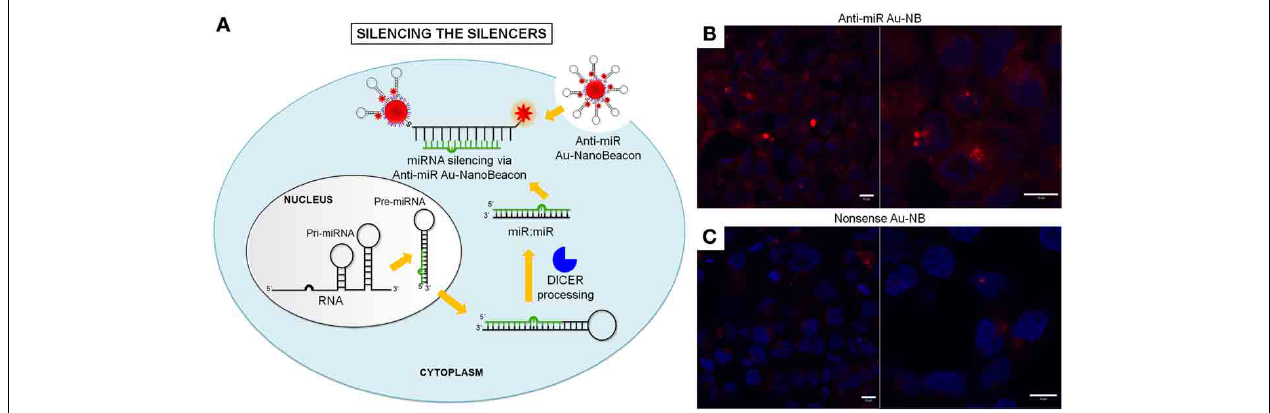
FIGURE 4 | Silencing the Silencers with hairpin-DNA-AuNPs—Gold nanobeacons.(A) SpecificAu-nanobeaconsarecapableofintersectingmiRNA pathway, leading to recovery of previously downregulated gene expression while simultaneously discriminating cells where silencing is occurring. The fluorescence signal may allow for tracking cell internalization and sub-cellular localization. The Au-nanobeacons’ potential for anti-cancer therapeutics via the silencing of the silencers is demonstrated by blocking the endogenous microRNA pathway via an Anti-miR Au-nanobeacon complementary to the